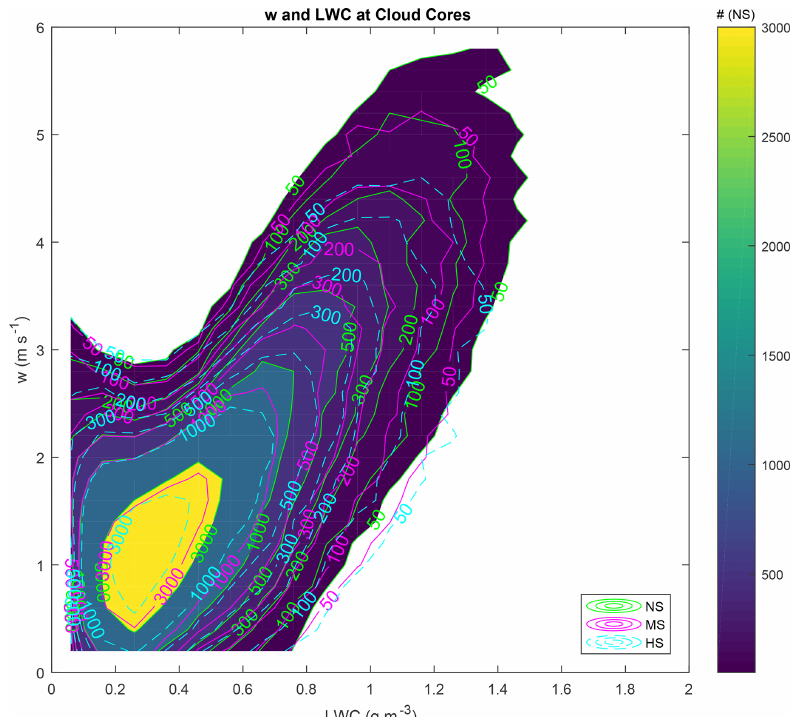
Figure 13. Distribution of the number of data points in the updraughts’ speed and w –liquid water content (LWC) space for the cloud cores. The colours and the black continuous lines represent the NS run. The MS and HS runs are represented by continuous magenta and dashed cyan lines, respectively. The w interval is between 0.1 and 5ms − 1 , with 0.2ms − 1 bins. The LWC interval is between 0.01 and 2gm − 3 , with 0.1gm − 3 bins. The curves in this figure represent the data point numbers calculated for those